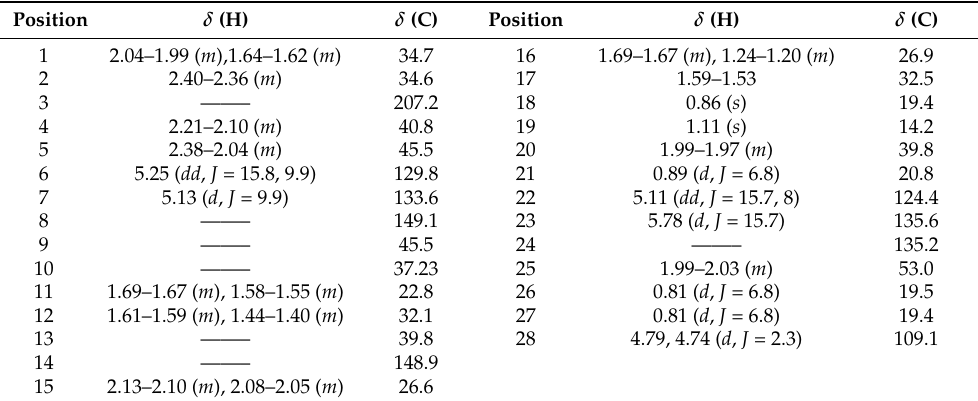
Figure 1. Compounds 1 – 4 isolated from T. apollinea leaf methanol extract. Compound 1 ; ergosta-6, 8 (14), 22-tetraen-3one, compound 2 ; lanceolatin A, compound 3 and 4 ; a mixture of stigmasterol and β -sitosterol. Table 1. 1 H- and 13 C-NMR Data (500 and 125 MHz, respectively; in CDCl 3 ) for TNS. δ in ppm, J in Hz.